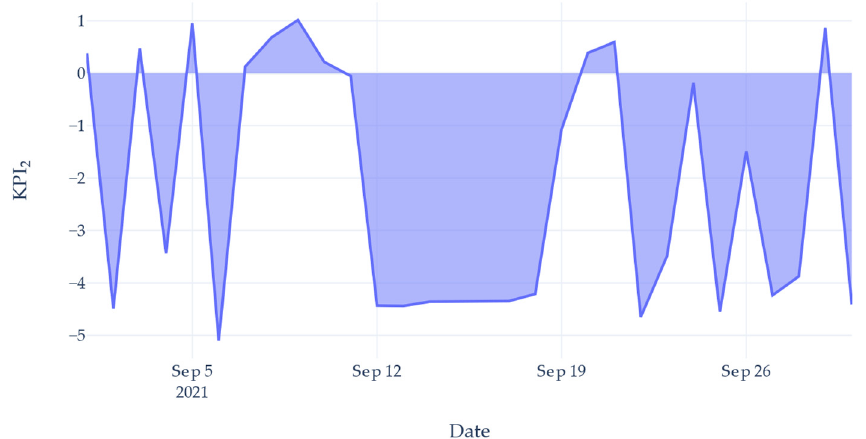
Figure 10. KPI 2 —gas consumption Figure 10. 𝐾𝑃𝐼 2 —gas consumption effectiveness.